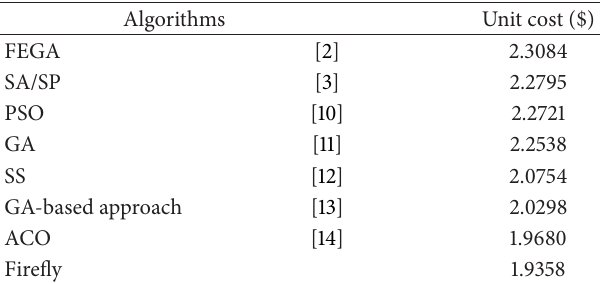
Table 3: Results of optimization using different